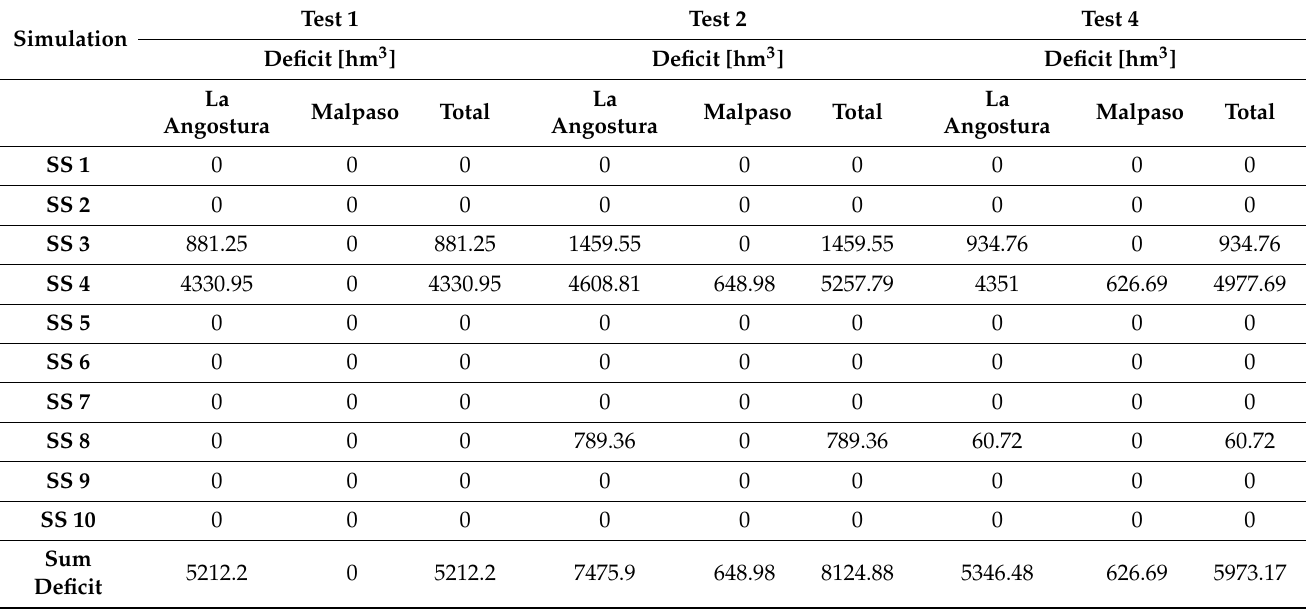
Table 13. Comparison of deficits during the long-term simulation of the 10 synthetic series for the three